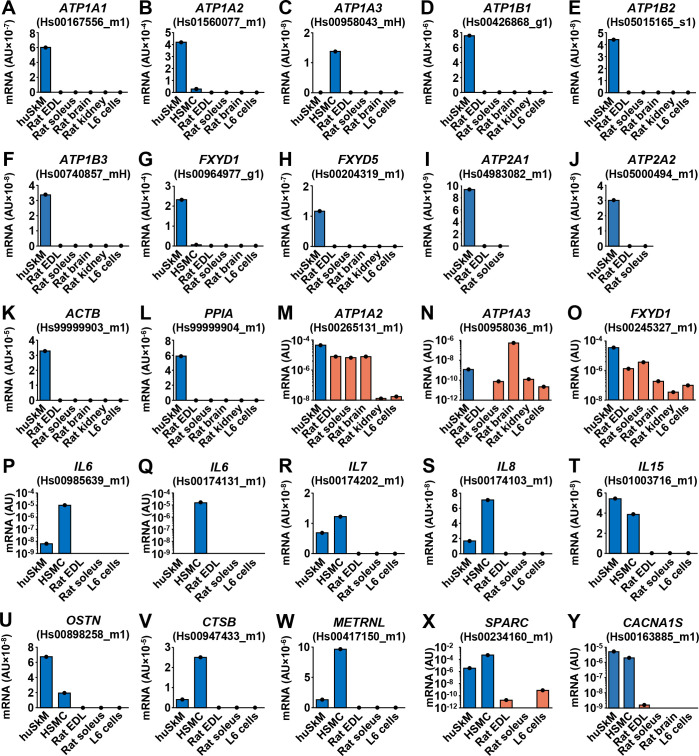
Validation of qPCR assays for estimation of gene expression in innervated human myotubes.(A-Y) Gene expression assays (see Methods) were validated by performing qPCR on human skeletal muscle (huSkM, m. semitendinosus), human skeletal muscle cells (HSMC, myotubes), and a panel of rat tissues (m. extensor digitorum longus (EDL) and m. soleus muscles, brain, and kidney) and L6 skeletal muscle cells. Each tissue or cell sample was measured in duplicate. Gene symbols: the same as in Figs 1 and 5. Endogenous control: 18S rRNA (18S).